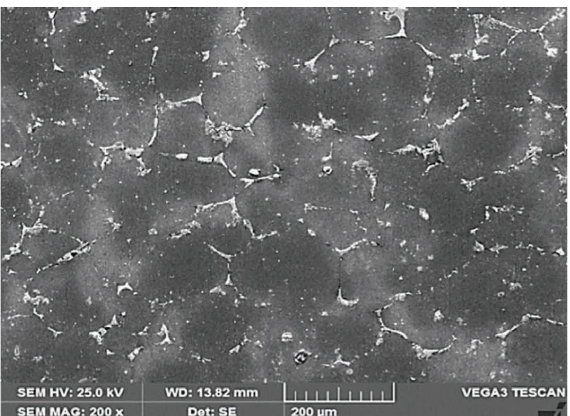
Figure 9: SEM micrograph of the section bonded at 500 ° C.